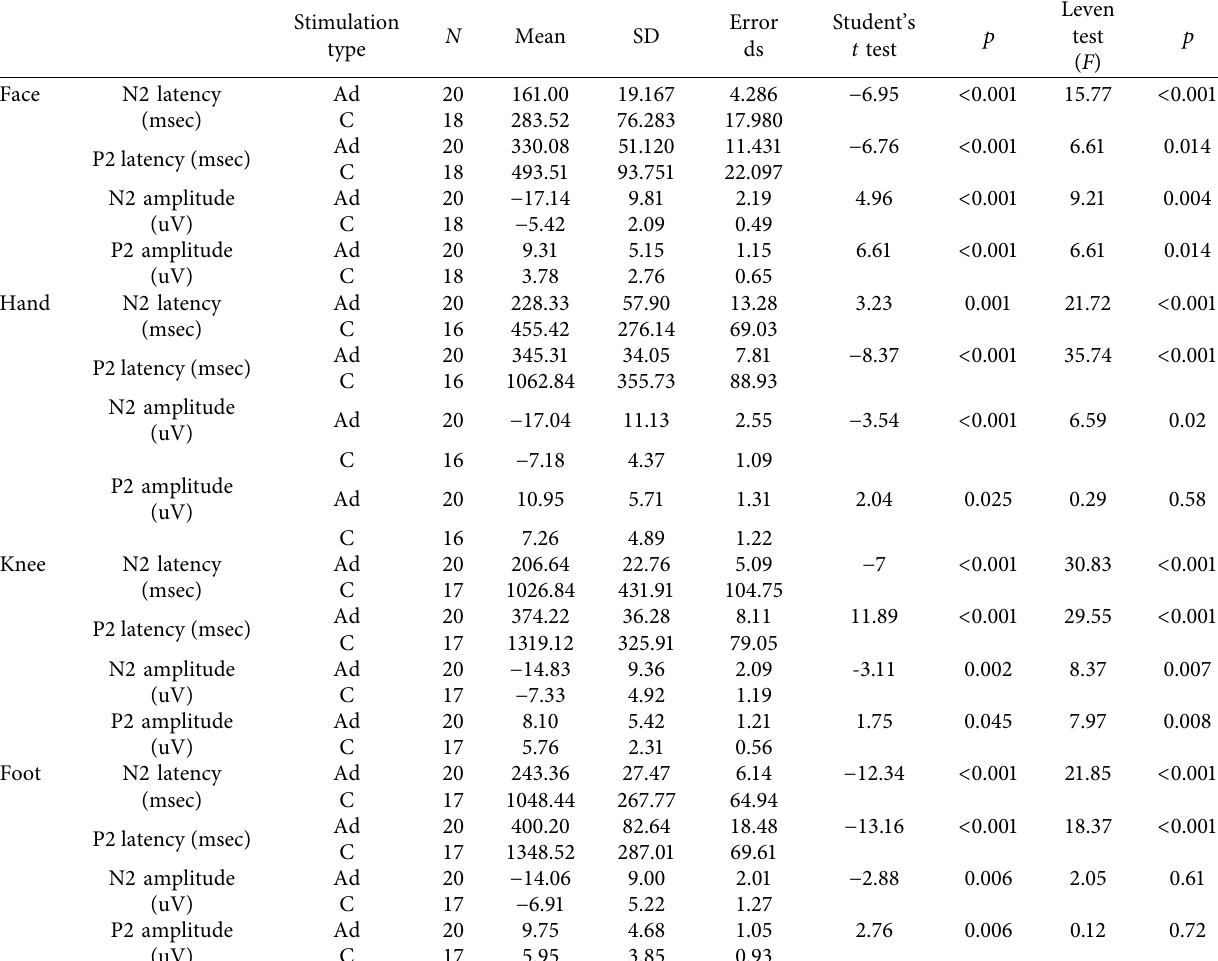
Table 3: Values of latencies and amplitudes of N2P2 components for the a-delta and C modalities of stimulation in 20 healthy subjects. Results of statistical analysis are